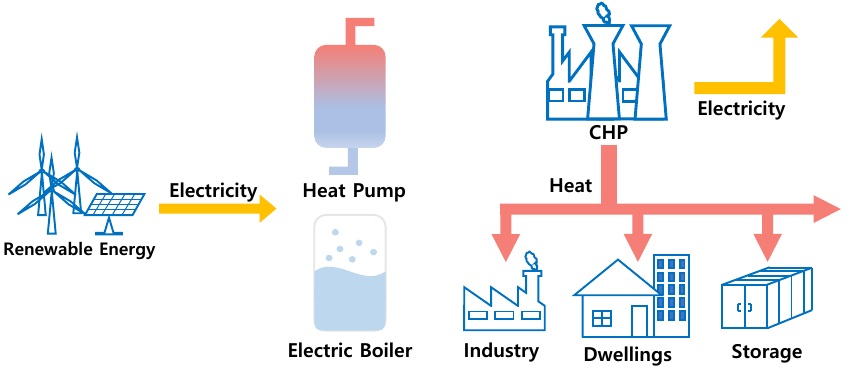
Figure 5. Concept of Power-to-Heat.